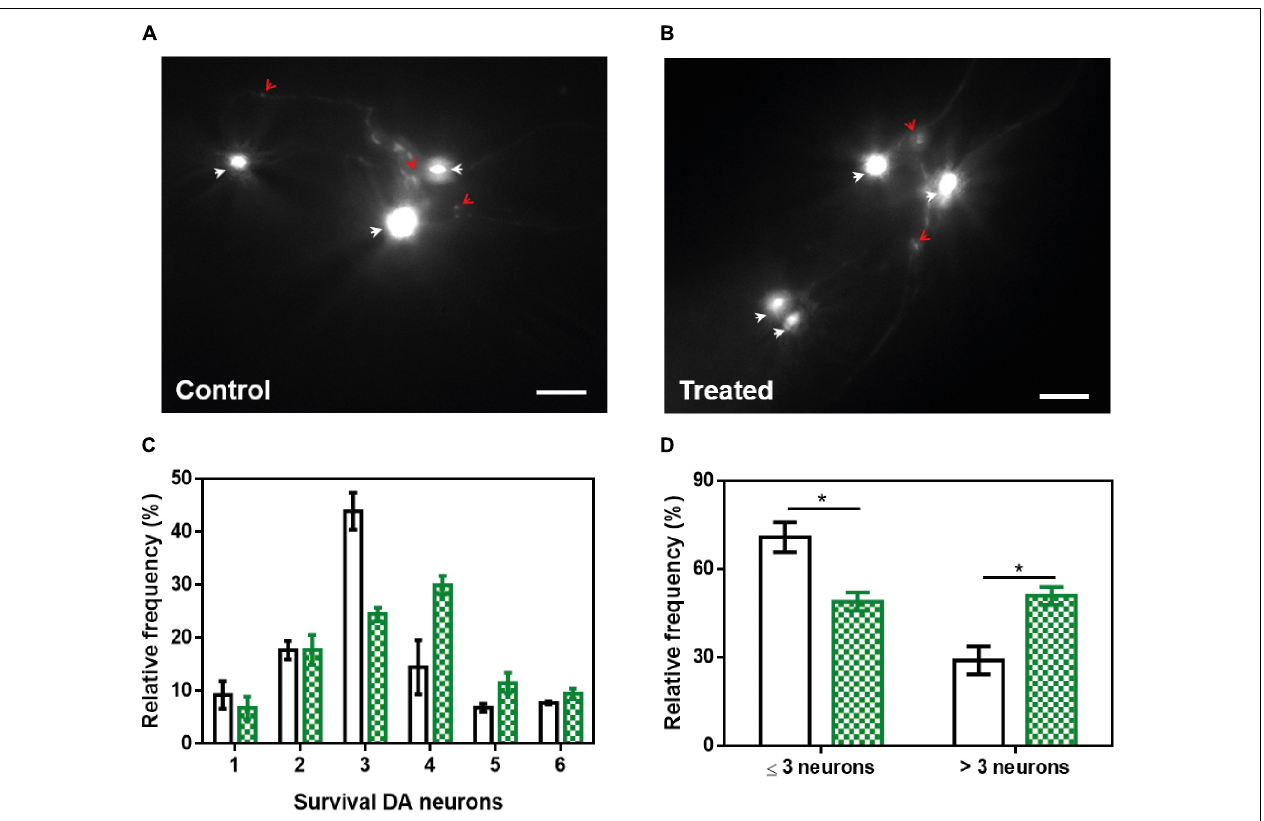
FIGURE 9 | Neuroprotective activity of ZPD-2 in a Caenorhabditis elegans model of PD. Representative images of GFP and α -Syn expressing anterior DA neurons in worms treated without (A) and with ZPD-2 (B) for 7 days after L4. Healthy neurons are labeled with white arrows. (C) Distribution of DA surviving neurons in the anterior region of worms. (D) Percentage of worms containing three neurons functional or less and more than three functional neurons after 7 days post-hatching. White bars indicate control samples while the green ones correspond to treated samples. ∗ p <